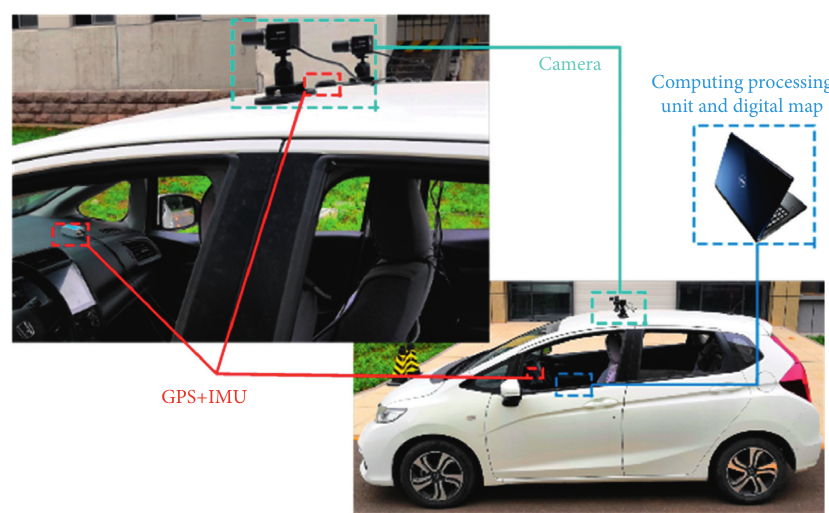
Figure 21: Schematic diagram of the test vehicle. Table 1: Some performance parameters of the MV-VDF300SC